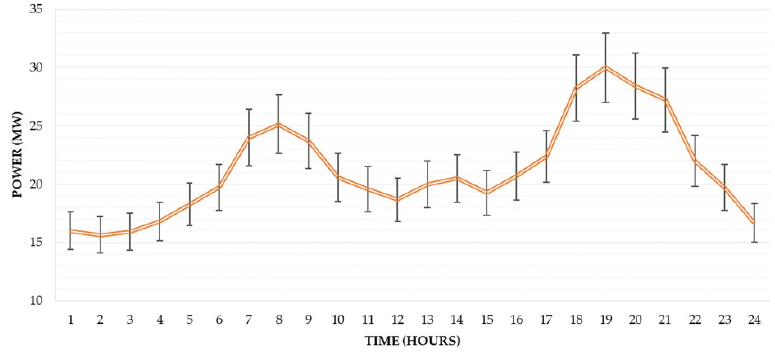
Figure 5. Forecasted Demand. Table 2. Battery Storage System’s Technical Data.